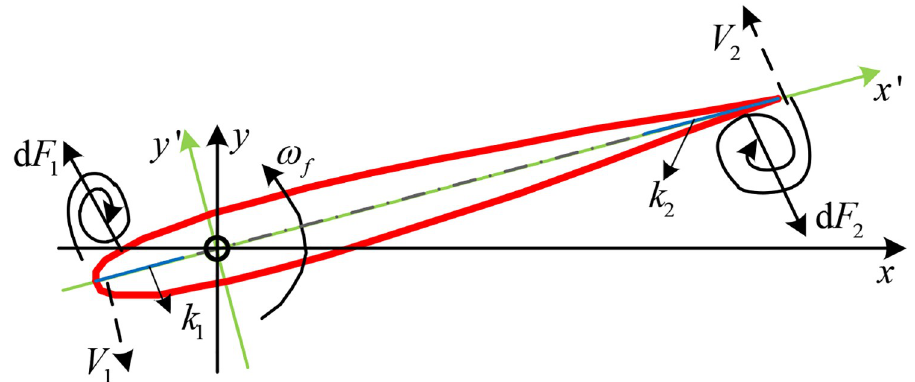
Fig 3. Diagram of the vortex drag